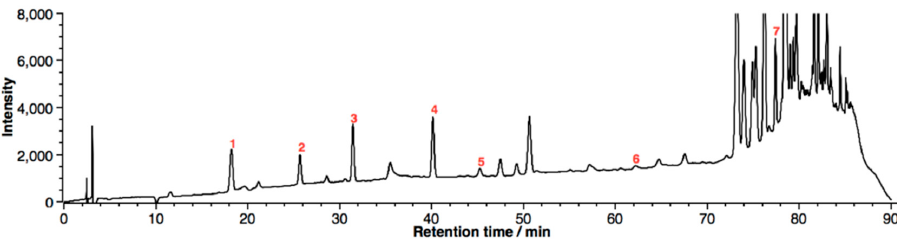
Table 1. LogD (pH 7.4) values of the phenolic compounds.